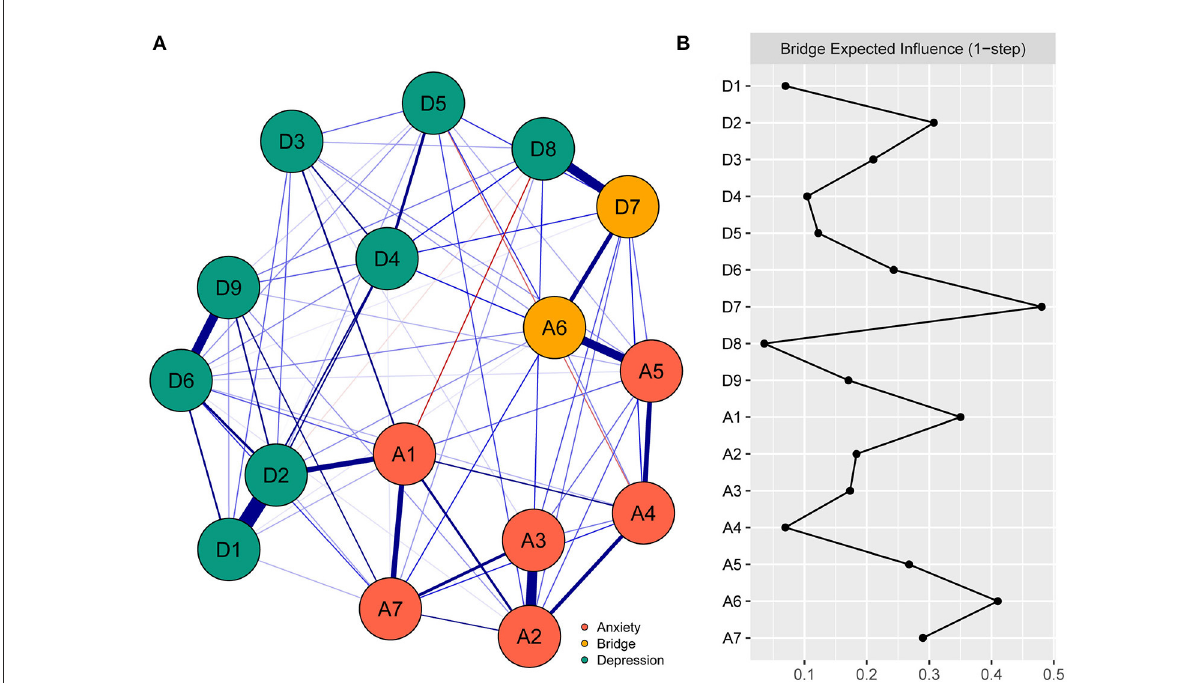
FIGURE2 The anxiety-depression network structure highlighting the bridge symptoms and the bridge expected influence indices in the functionally impaired elderly. (A) The anxiety-depression network structure highlighting the bridge symptoms. The nodes in the network represent symptoms of anxiety and depression, and bridge symptoms are highlighted in orange. The edges represent correlations of symptoms, blue edges and red edges represent positive and negative correlations, respectively, and thicker edges represent higher correlations. (B) The bridge expected influence indices in the anxiety-depression network of the functionally impaired elderly (raw score). A1, Nervousness or anxiety; A2, Uncontrollable worry; A3, Worry too much; A4, Trouble relaxing; A5, Restlessness; A6, Irritable; A7, Afraid something will happen; D1, Anhedonia; D2, Depressed or sad mood; D3, Sleep diculties; D4, Fatigue; D5, Appetite changes; D6, Feeling worthlessness; D7, Concentration diculties; D8, Psychomotor agitation/retardation; D9, Thoughts of